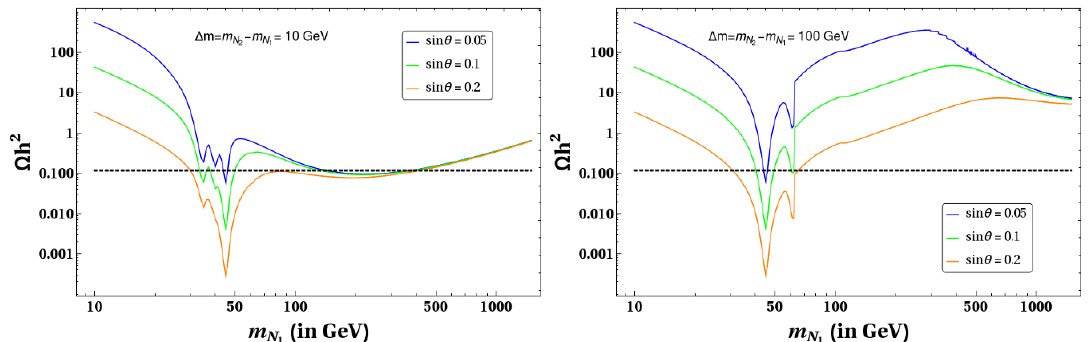
Figure 26 . Relic density of N 1 as a function of DM mass, m N sin (cid:18) = 0 : 05 (blue), sin (cid:18) = 0 : 1 (green) and sin (cid:18) = 0 : 2 (orange). Each plot corresponds to (cid:12)xed (cid:1) m : = 10 GeV (left), 100 GeV (right). Black dashed line indicates observed relic density 0 : 1133 (cid:10) DM h 2 0 : (cid:20)